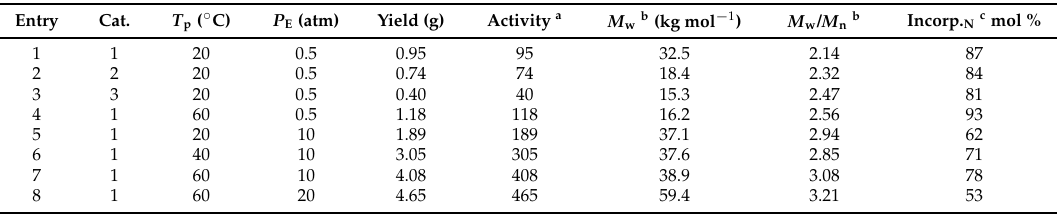
Table 3. Copolymerizations of ethylene and norbornene with 1–3 /MAO.